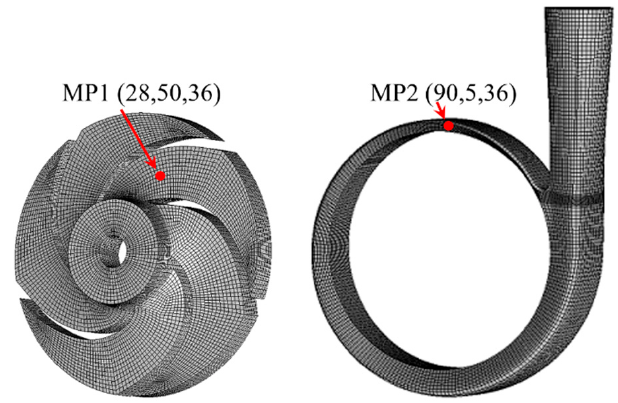
Figure 3. Meshes in the fluid domains of the impeller and volute.